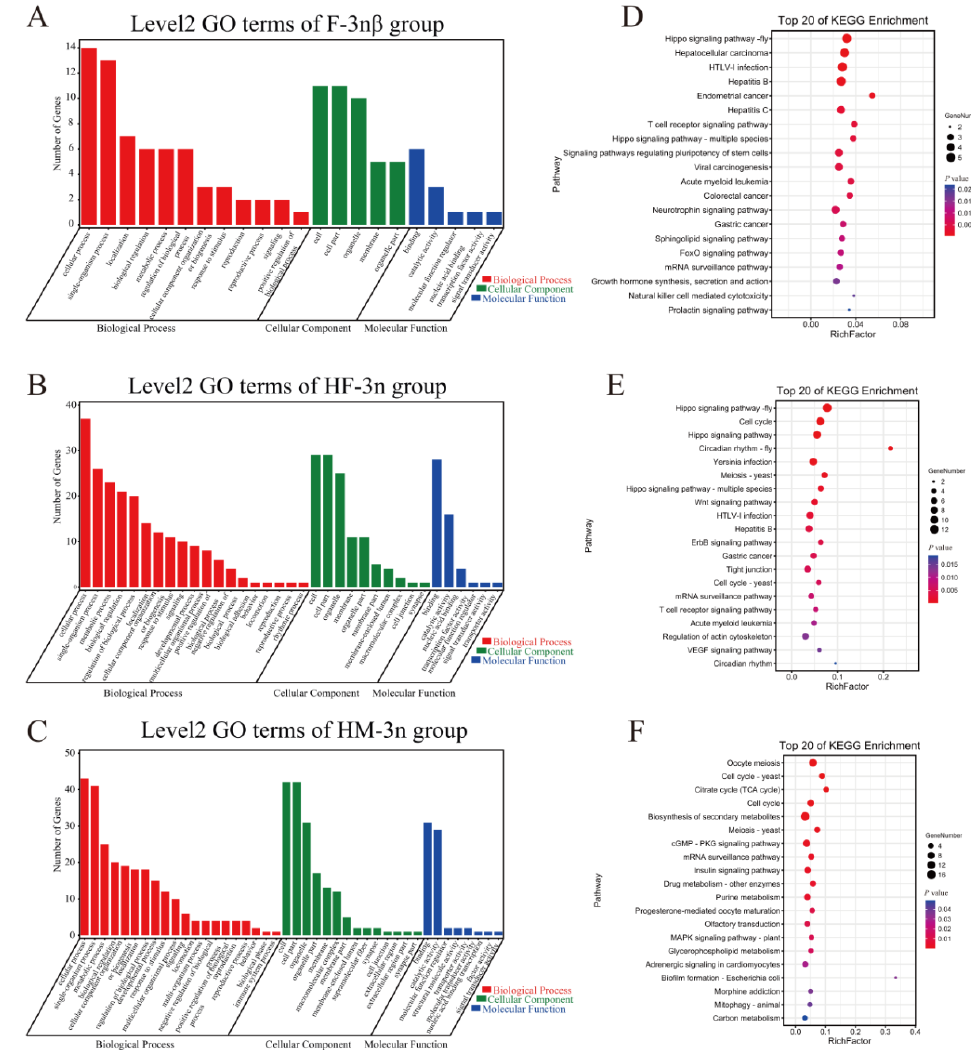
Figure 4. Gene Ontology (GO) enrichment analysis of differentially expressed genes of C. gigas revealed highly enriched biological processes associated with detected DEGs ( A – C ). Based on the GO results, cellular process, DNA binding, and catalytic activity were the most enriched GO terms in sterile oysters compared to fertile ones. KEGG enrichment of differentially expressed genes with top 20 terms ( D – F ); “GeneNumber” is the number of genes that were enriched in the term; “RichFactor” refers to the ratio of the number of genes in the term to the total number of